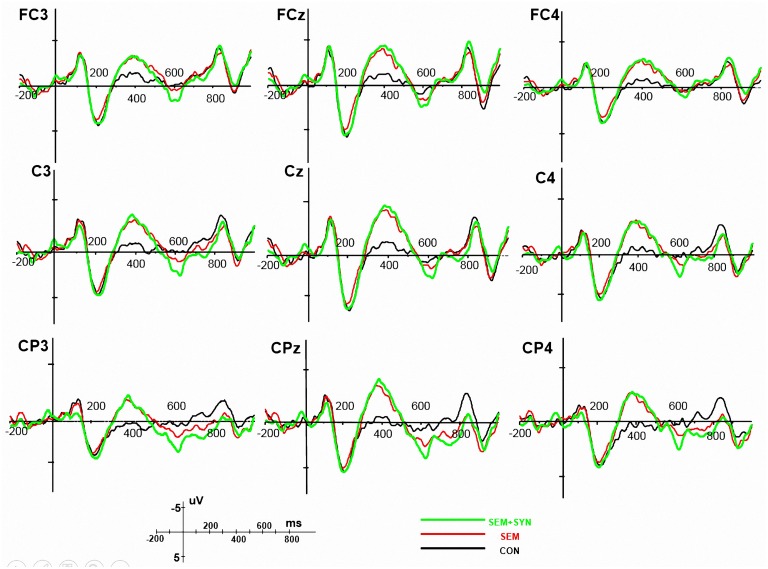
Grand average of ERPs.Average ERPs from the onset of the critical words (NP2) up to 1000 ms thereafter for congruent condition (CON, black line), semantic violation condition (SEM, red line), and combined semantic and syntactic violation condition (SEM+SYN, green line) at 9 representative electrodes. Negativity is plotted upwards.